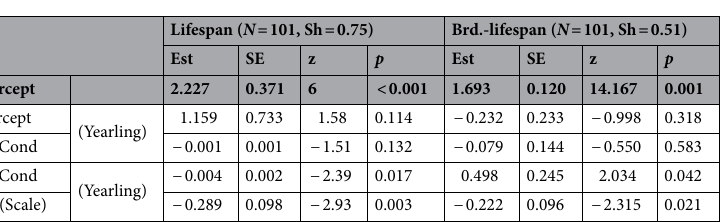
Figure 1. Age specific reproductive performance in peregrines. We show changes in ABR (Averaged Breeding Residual, the number of fledglings produced by a pair minus the average number of fledglings produced by all monitored nests in the population in that year) with for females in ( a ) and for males in ( b ), and variation with age in relative incubation start date for females in ( c ) and form males in ( d ). Points represent observed values, while lines are smoothers fitted over multi-model average predicted values. Ages are in calendar years. The plot for female changes in laying dates, ( d ) includes recruitment age interacting with age; broken lines and empty circles indicate females recruited as yearlings, while the full line and circles show the relationships for females recruited at 3 cy or later. Variation in laying dates show the average trend accounting for conditions experienced upon recruitment. Separate trends for contrasting recruitment conditions are shown in Fig. S1. In some plots, the trends are not centred on zero because ABR and relative laying dates were calculated using all monitored breeding pairs, but age-specific reproductive performance was modelled using only the subset of individuals of known age.